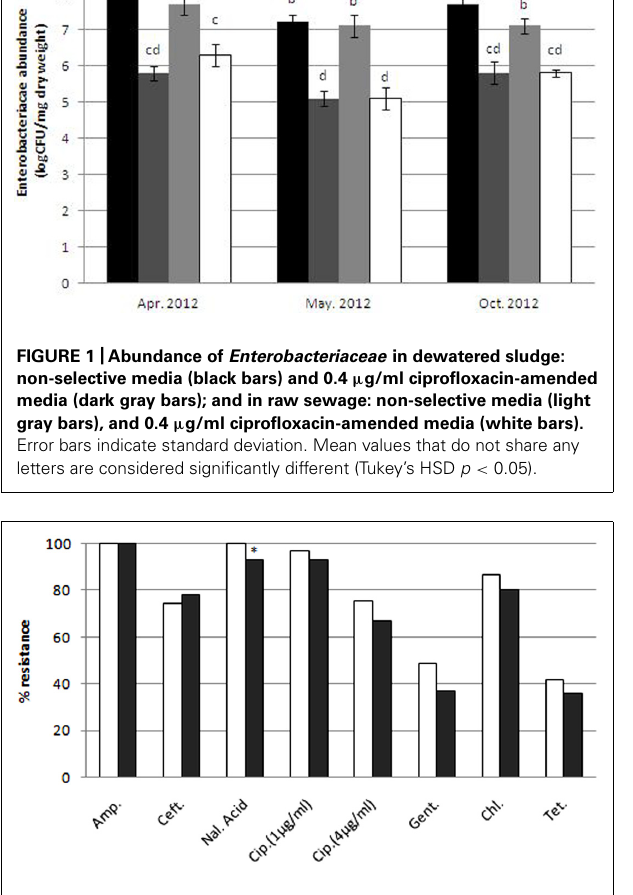
FIGURE 2 | Resistance of sludge (white bars) and raw sewage (gray bars) intermediate ciprofloxacin-resistant isolates to additional antibiotic compounds at MIC concentrations. Asterisk indicates statistically significant (Fisher’s exact test p < 0.05) differences between sampling locations.